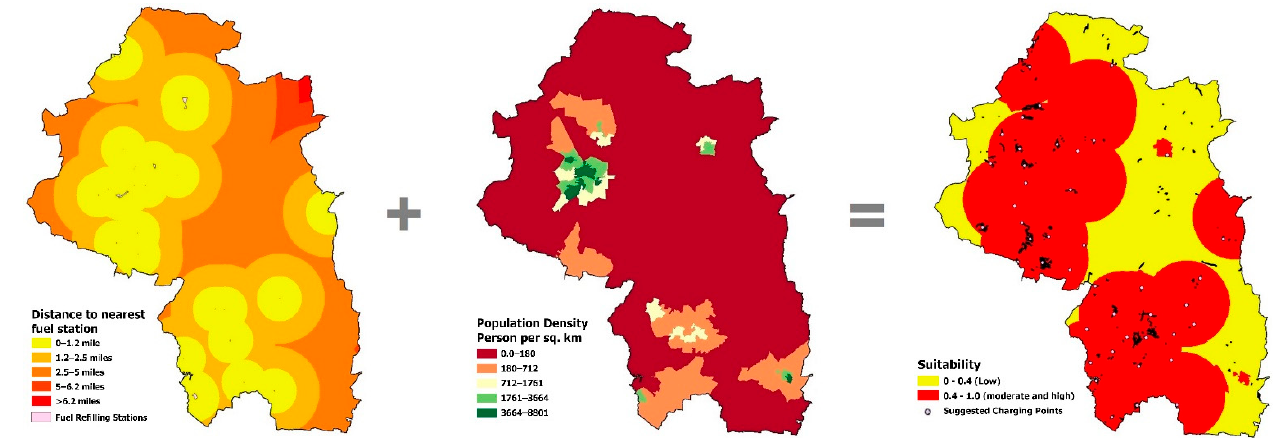
Figure 6. Suitability factors mapping for Winchester District. Petrol station locations’ ( left ) population distribution ( centre ), and combined suitability map ( right ).